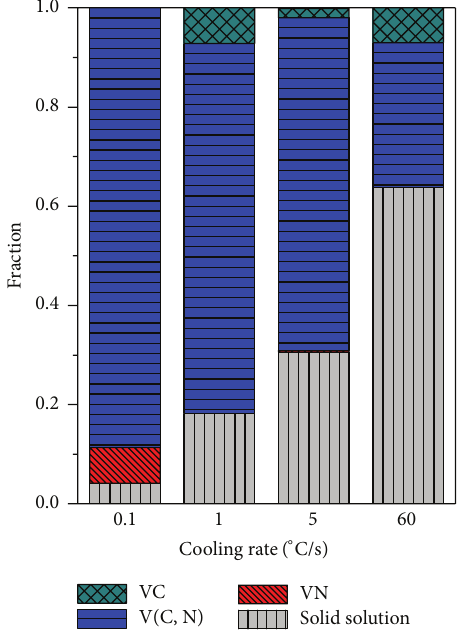
Figure 3: Calculated fraction of different precipitates of Vanadium compared with the fraction of Vanadium left in the solid solution by different cooling